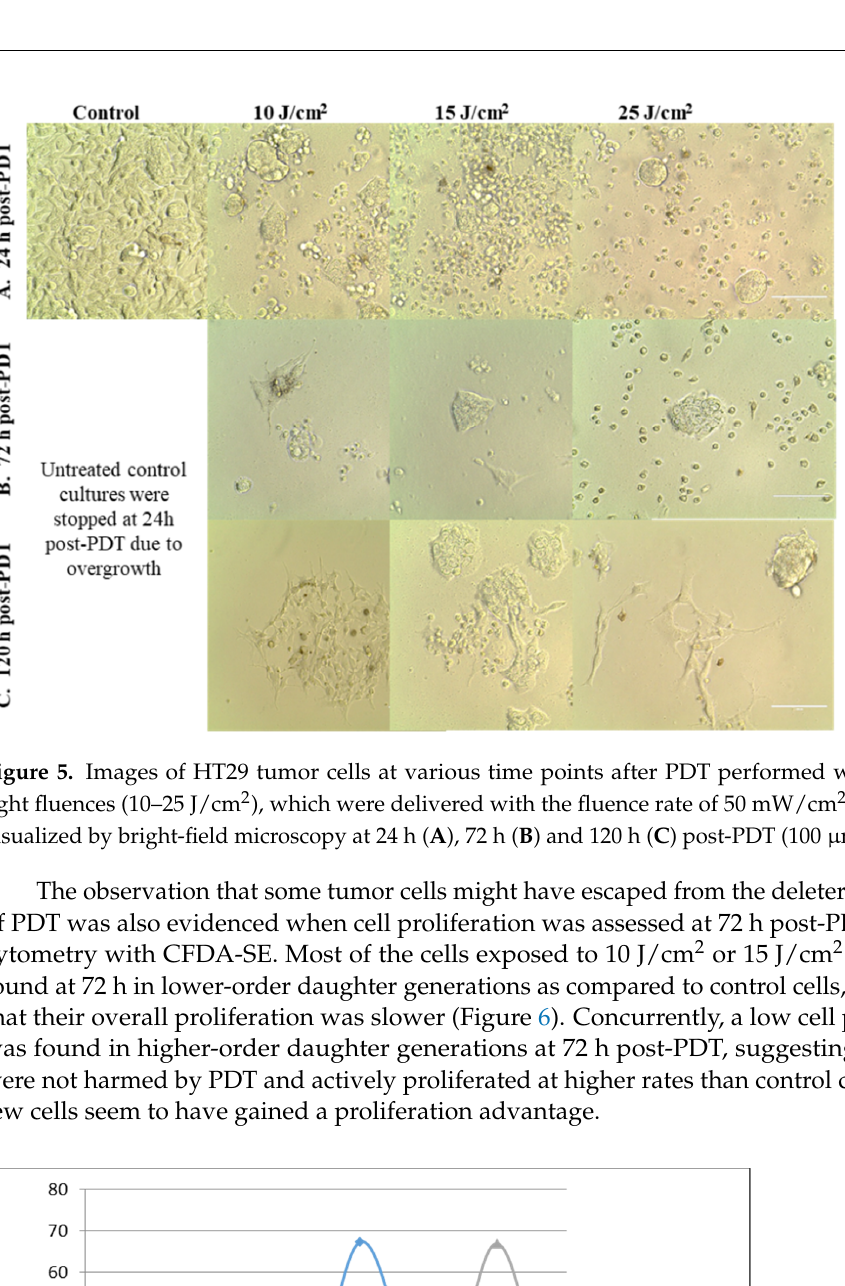
5 of 25 Figure 4. The dependence of MTS reduction by PDT-treated HT29 tumor cells on the fluence of the activation light delivered at a fluence rate of 50 mW/cm 2 . Results are presented as PDT effect (mean ± SEM) in triplicate samples. PDT effect was calculated as OD in PDT-treated samples divided by the mean value of OD in control samples. Comparison between samples was performed using Student’s t -test considering unequal variances: comparison between PDT regimens at a specific time-point: * p < 0.05, *** p < 0.001; comparison between samples at 24 h and 72 h: ### p < 0.001.